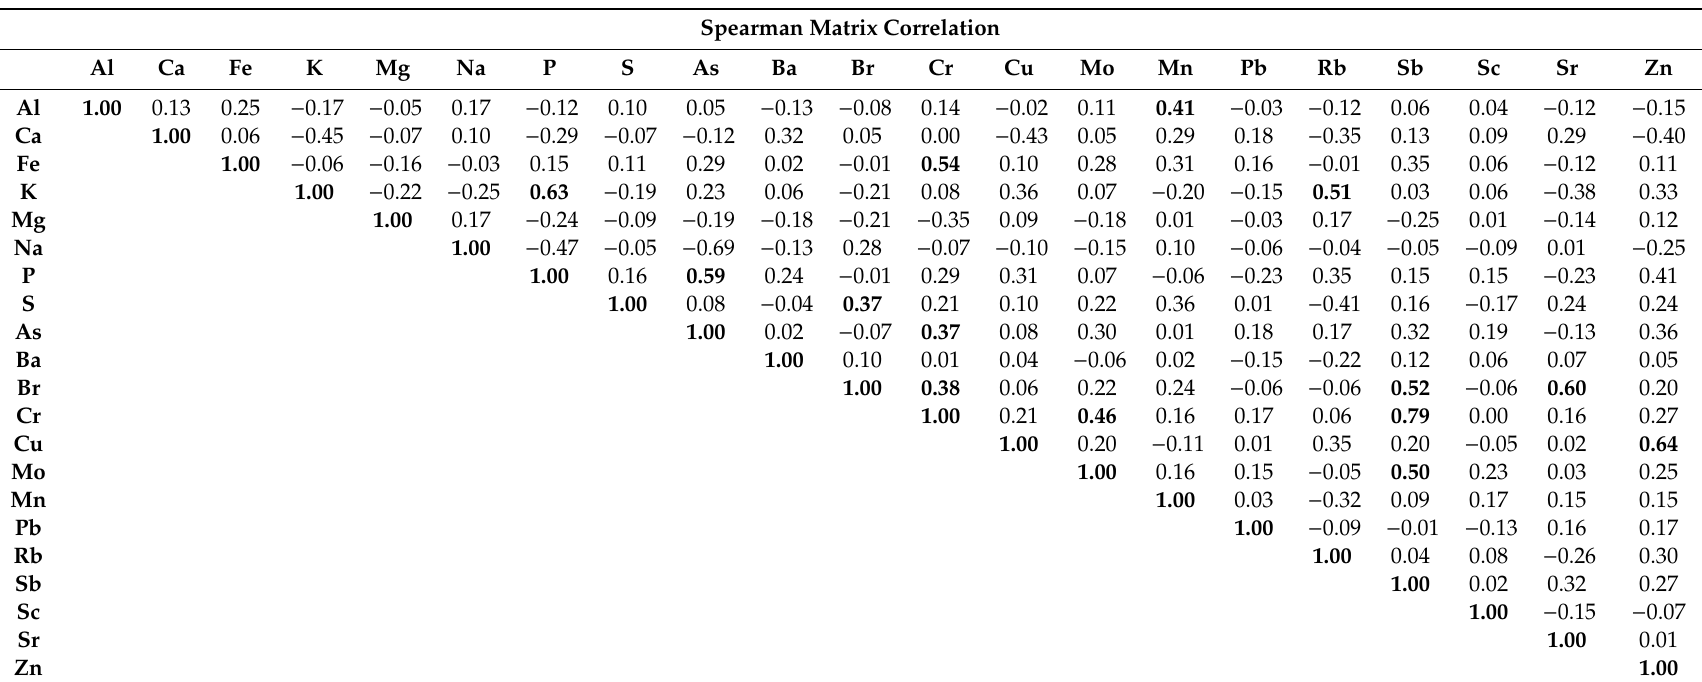
Table 3. Correlation matrix for selected elements ( p < 0.01; ρ =